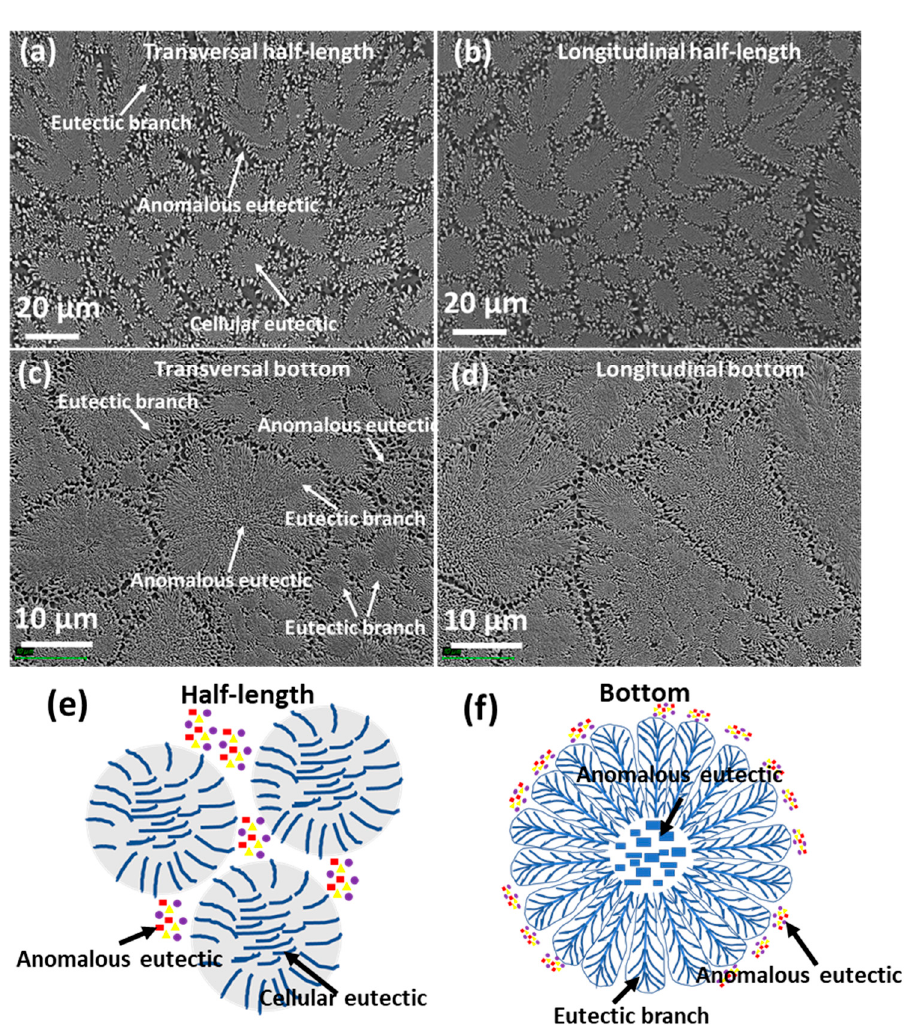
Figure 3. SEM secondary electron images showing the microstructure of half-length of the sample ( a ) transversal ( b ) longitudinal; the microstructure of the bottom part ( c ) transversal ( d ) longitudinal; schematic of the microstructure in half-length ( e ) bottom ( f ).